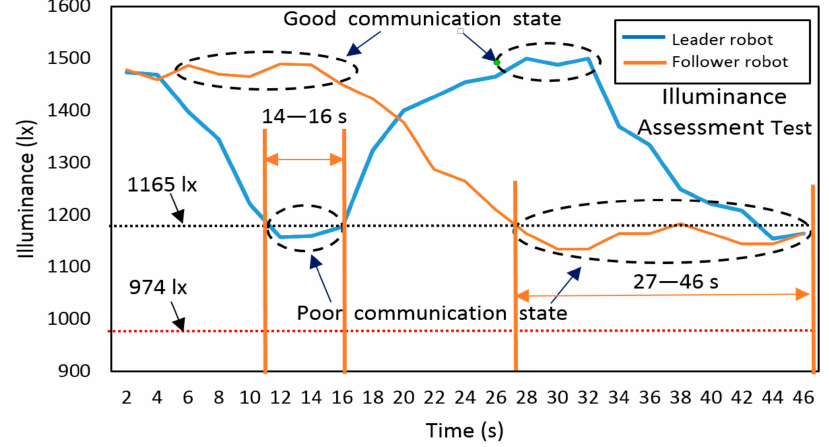
Figure 16. Comprehensive illuminance assessment test of RCS in the transparent